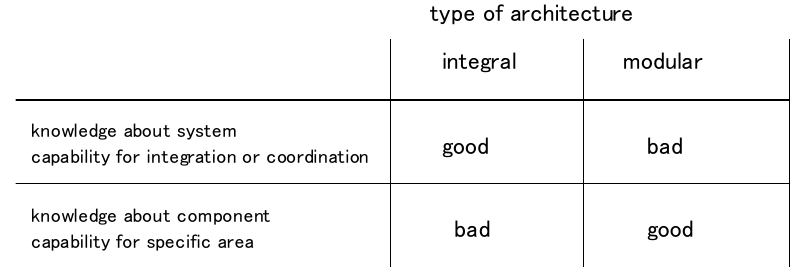
Figure 1. Relationships between knowledge and architecture